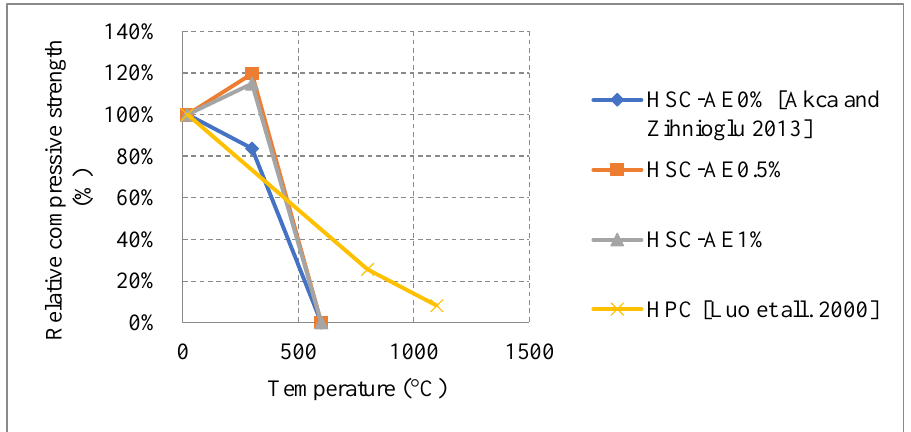
Figure 18. Relative compressive strength of furnace cooled HSC with different constituents. AE: Air Entrained [78,79].